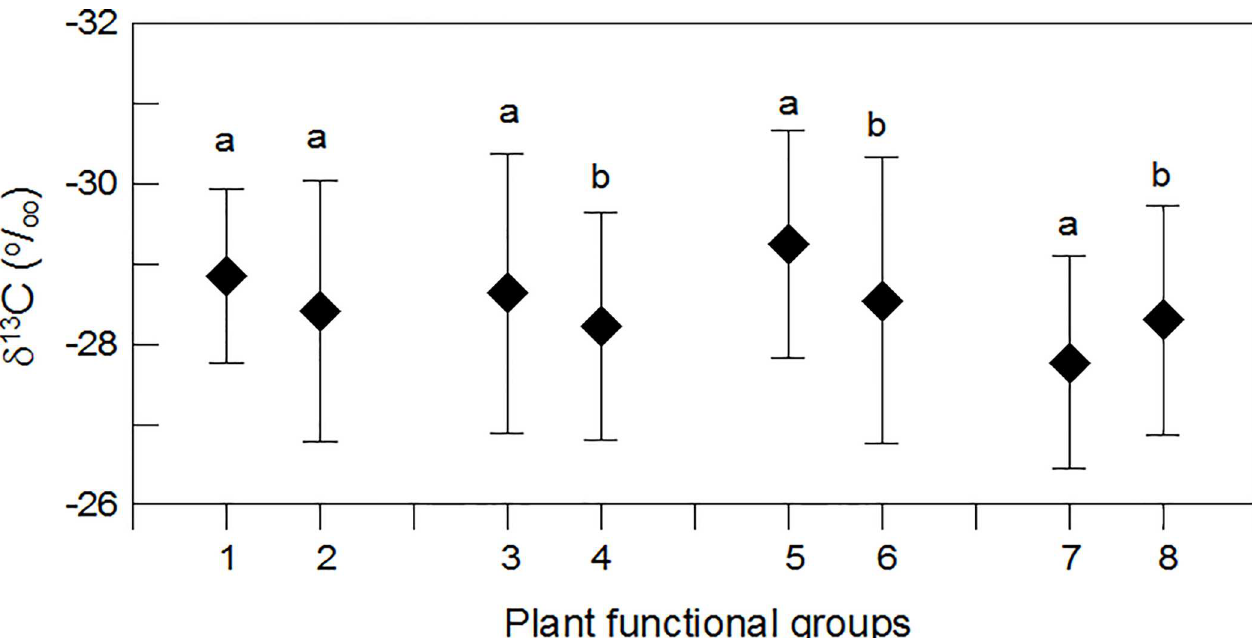
Fig 1. Mean leaf δ 13 C values ± 1SD across different plant functional groups. Different letters indicatesignificantdifference at the 0.05 level. 1: ferns; 2: seed plants; 3: herbaceousplants; 4: woody plants; 5: annualherbaceousplants; 6: perennialherbaceous plants; 7: evergreenwoody plants; 8: deciduouswoody plants.